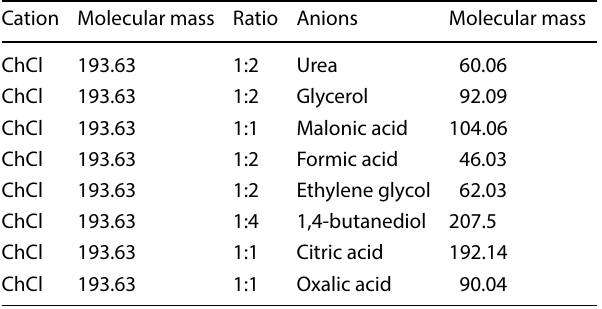
Table 1 Compositions and mole ratio of synthesized DESs Cation Molecular mass Ratio Anions Molecular